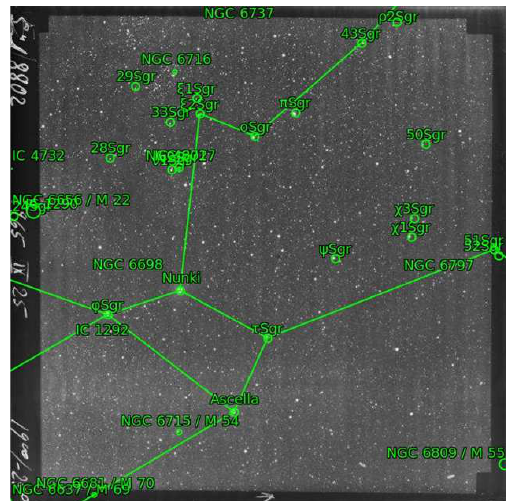
Figure 1: Example of digitized Bamberg southern sky patrol plate processed by astrometry.net tools: field